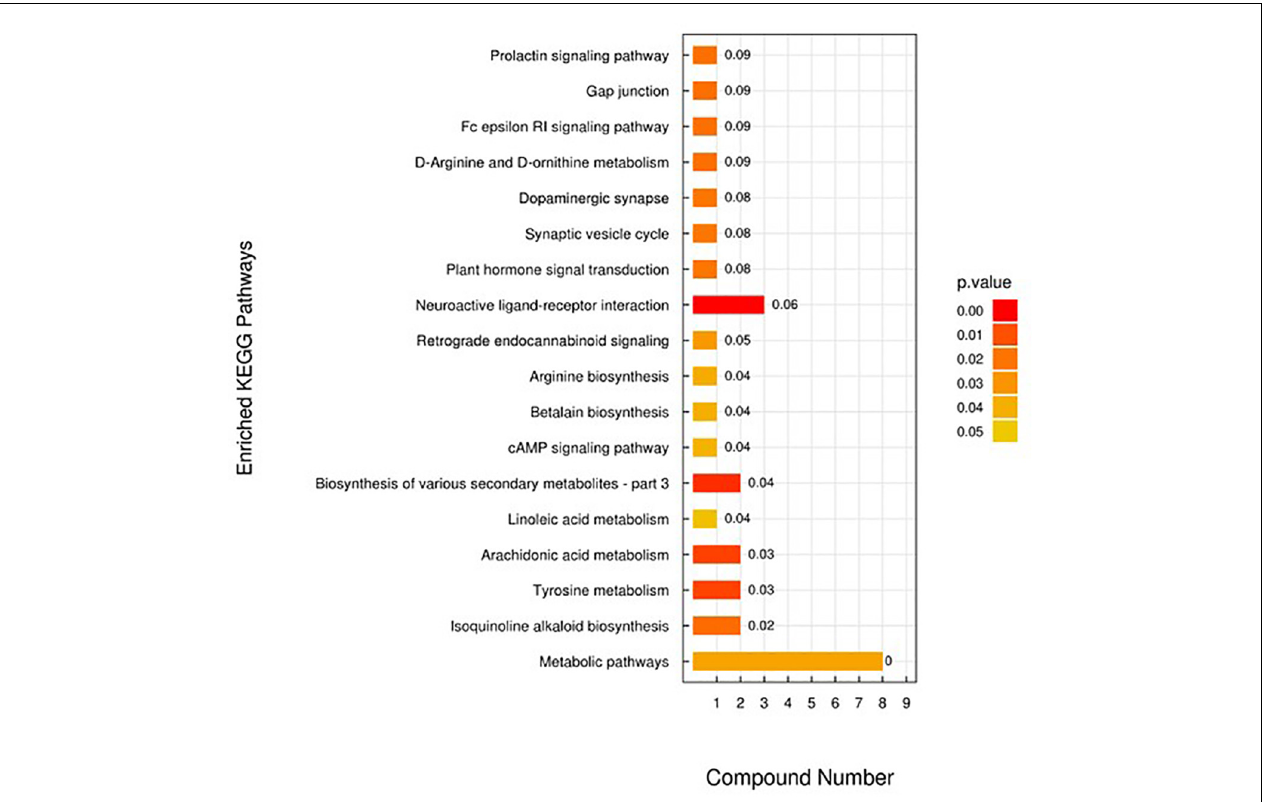
FIGURE 4 | Upregulated and downregulated metabolic pathways in abalone from groups A and